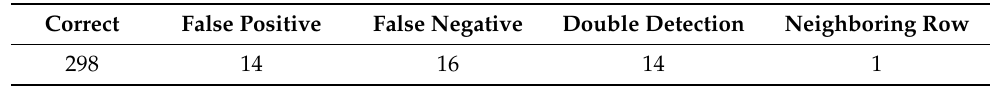
Table 2. Performance of the proposed method.